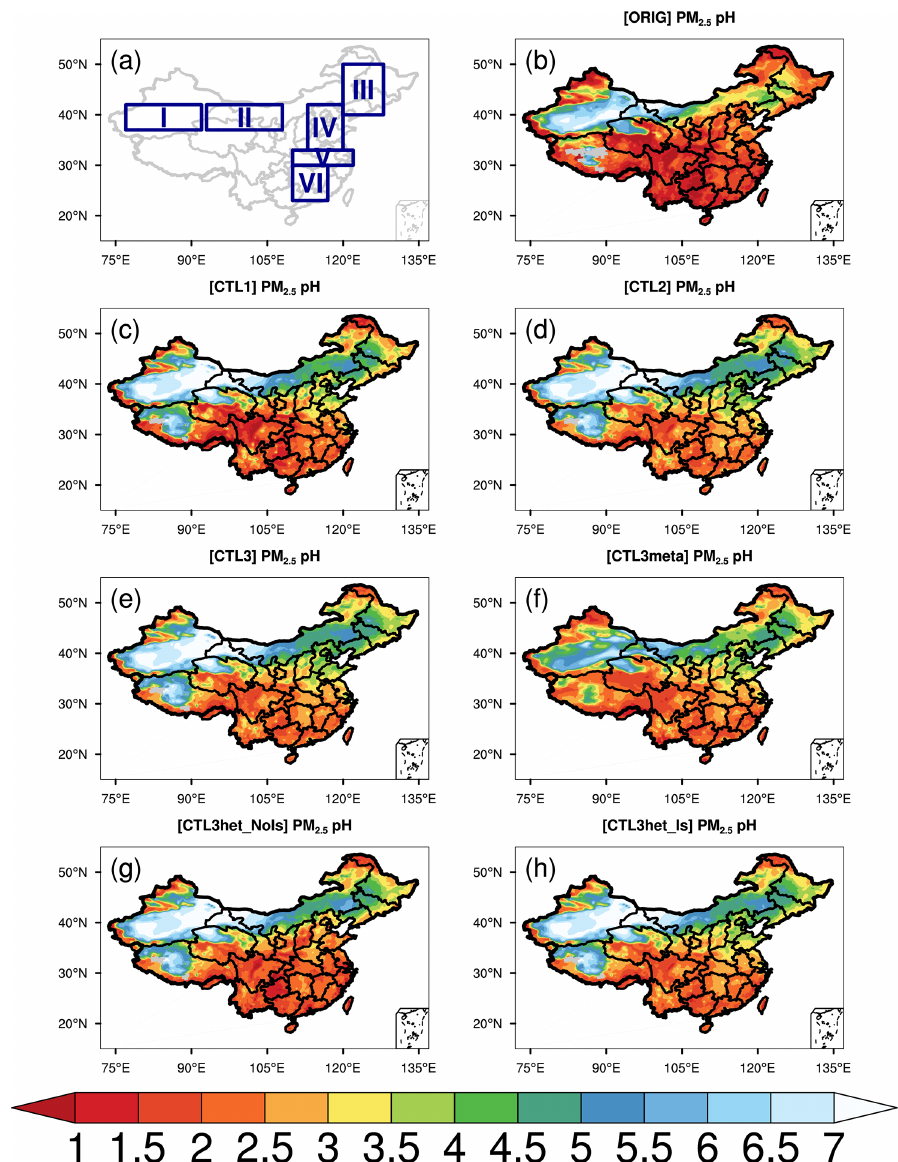
Figure 1. (a) Six subregions. (b–h) Spatial distributions of mean surface PM 2 . 5 pH (liquid water content (LWC) weighted average pH) during the study period of 15 October–2 November 2014 predicted by (b) ORIG, (c) CTL1, (d) CTL2, (e) CTL3, (f) CTL3meta, (g) CTL3het_NoIs, and (h) CTL3het_Is. “I” in (a) represents the Taklimakan Desert (TD), “II” represents the Gobi Desert (GD), “III” represents the Northeast Plain (NEP), “IV” represents the North China Plain (NCP), “V” represents the middle and lower reaches of Yangtze River plain (YR), and “VI” represents South China